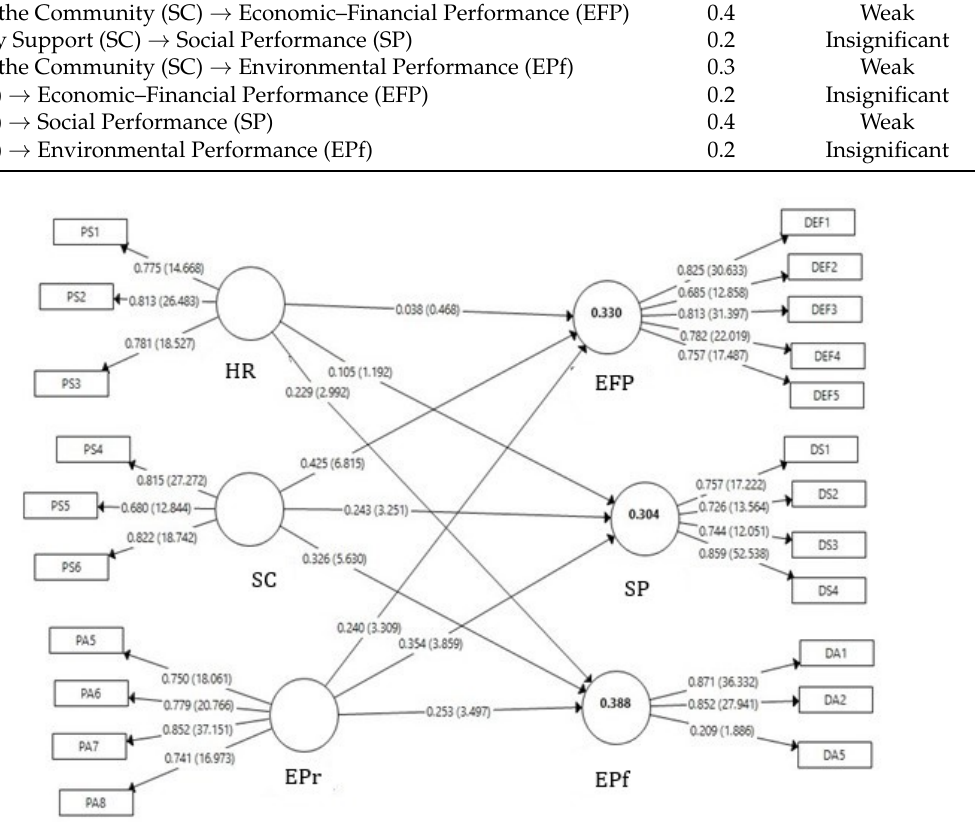
Figure 2. Structural coefficients and t-values between constructs (between parentheses).